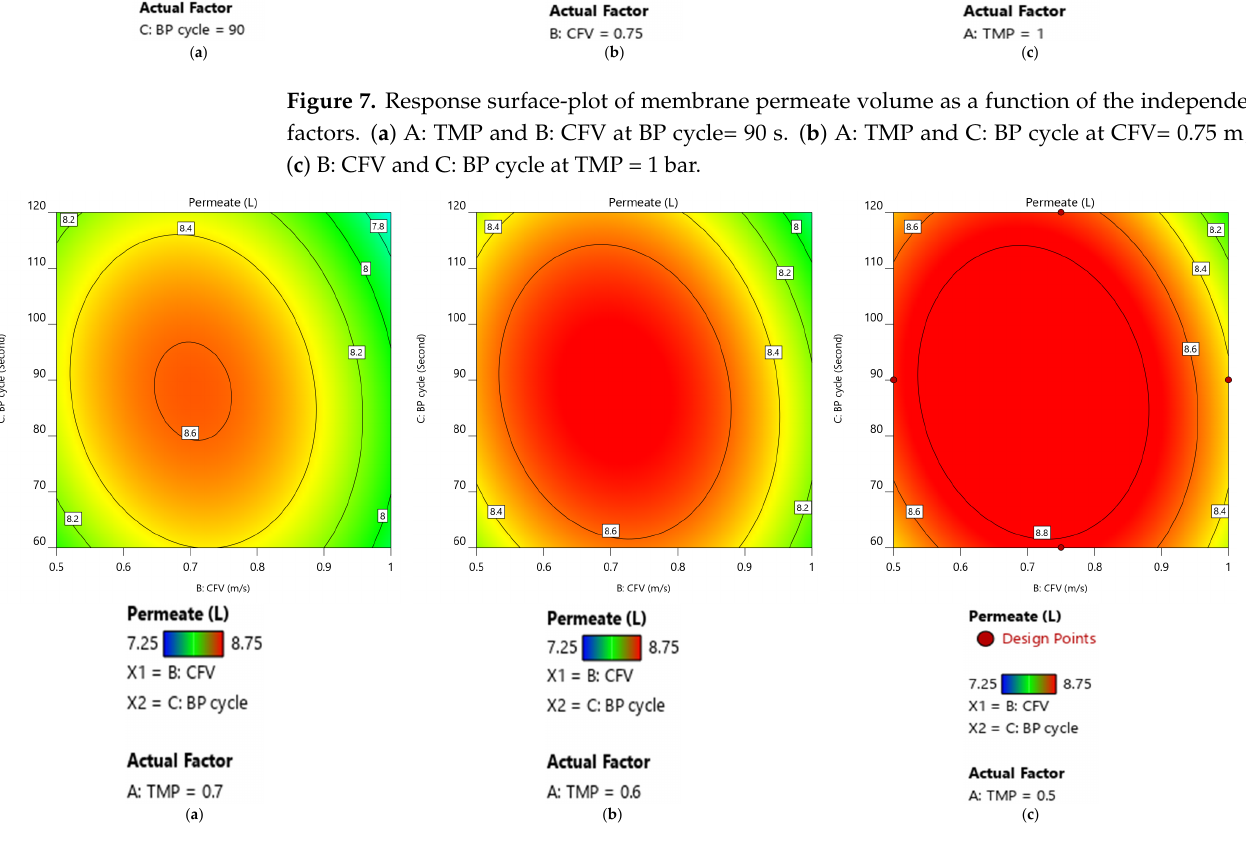
Figure 8. Membrane ‐ permeate volume contour as a function of CFV and Pulsatile cycle at a sequence of TMP values 0.7, 0.6, and 0.5 bar, respectively. ( a ) B: CFV and C: BP cycle at TMP = 0.7 bar. ( b ) B: CFV and C: BP cycle at TMP = 0.6 bar. ( c ) B: CFV and C: BP cycle at TMP = 0.5 bar.